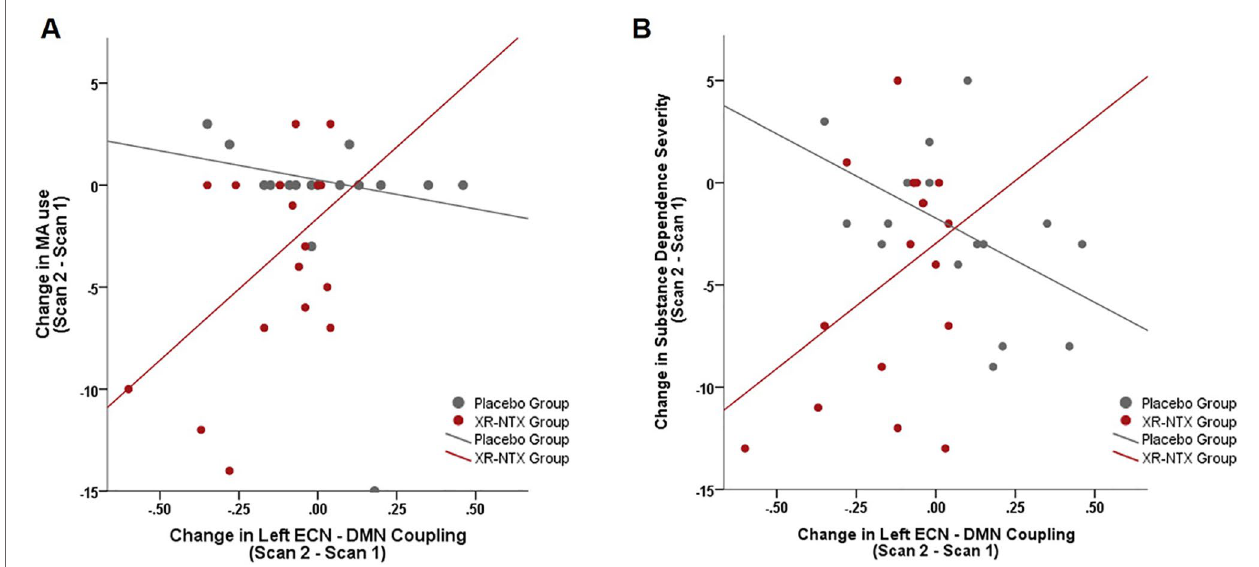
FIGURE 4 | Change in Left ECN–DMN correlations is associated with change in MA use and Substance Dependence Severity. (A) In the XR-NTX group, individuals with greater reductions in network correlations exhibit greater reductions in MA use between Scan 1 and Scan 2 with opposite effects in the Placebo Group (p = 0.019). (B) In the XR-NTX group, individuals with greater reductions in network correlations exhibit greater reductions in Substance Dependence Severity scores between Scan 1 and Scan 2 with opposite effects in the Placebo Group (p =